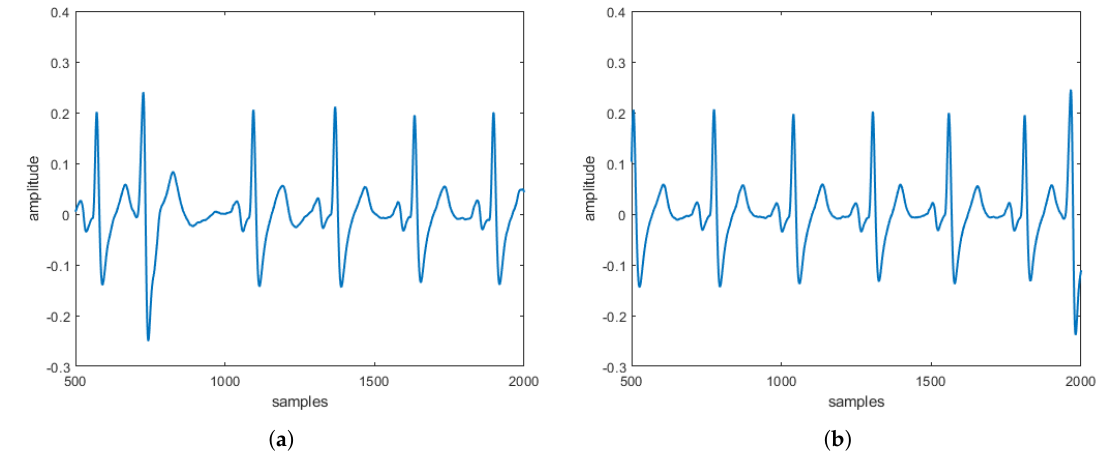
Figure 8. Case (a) of the proposed methodology: ( a ) premature ventricle contraction and ( b ) typical ECG with premature ventricle